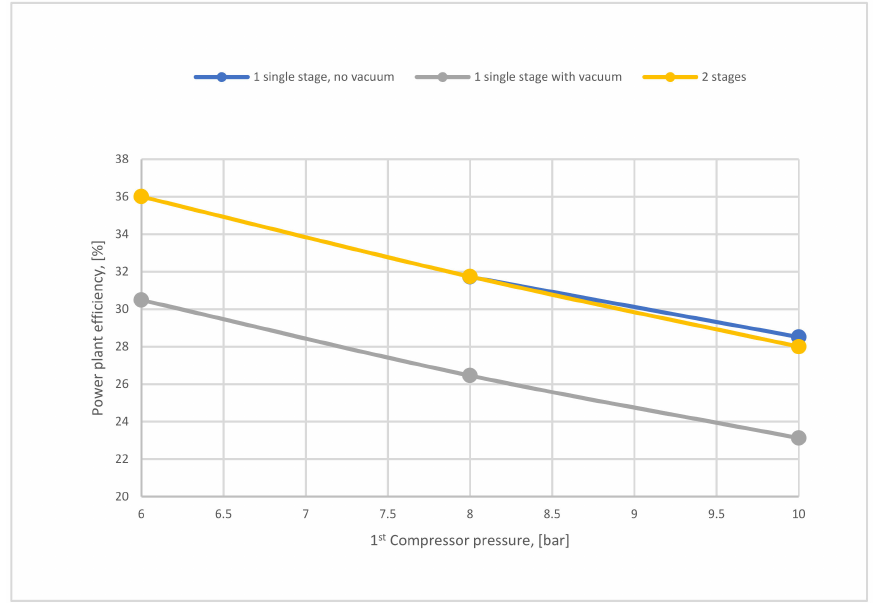
Figure 22. Power plant efficiency variation of 1-single stage (with and without VP) depending on 1st compressor pressure at 200,000 m 2 SA 1 , 40,000 m 2 SA 2 , and 4 bar of CP 2